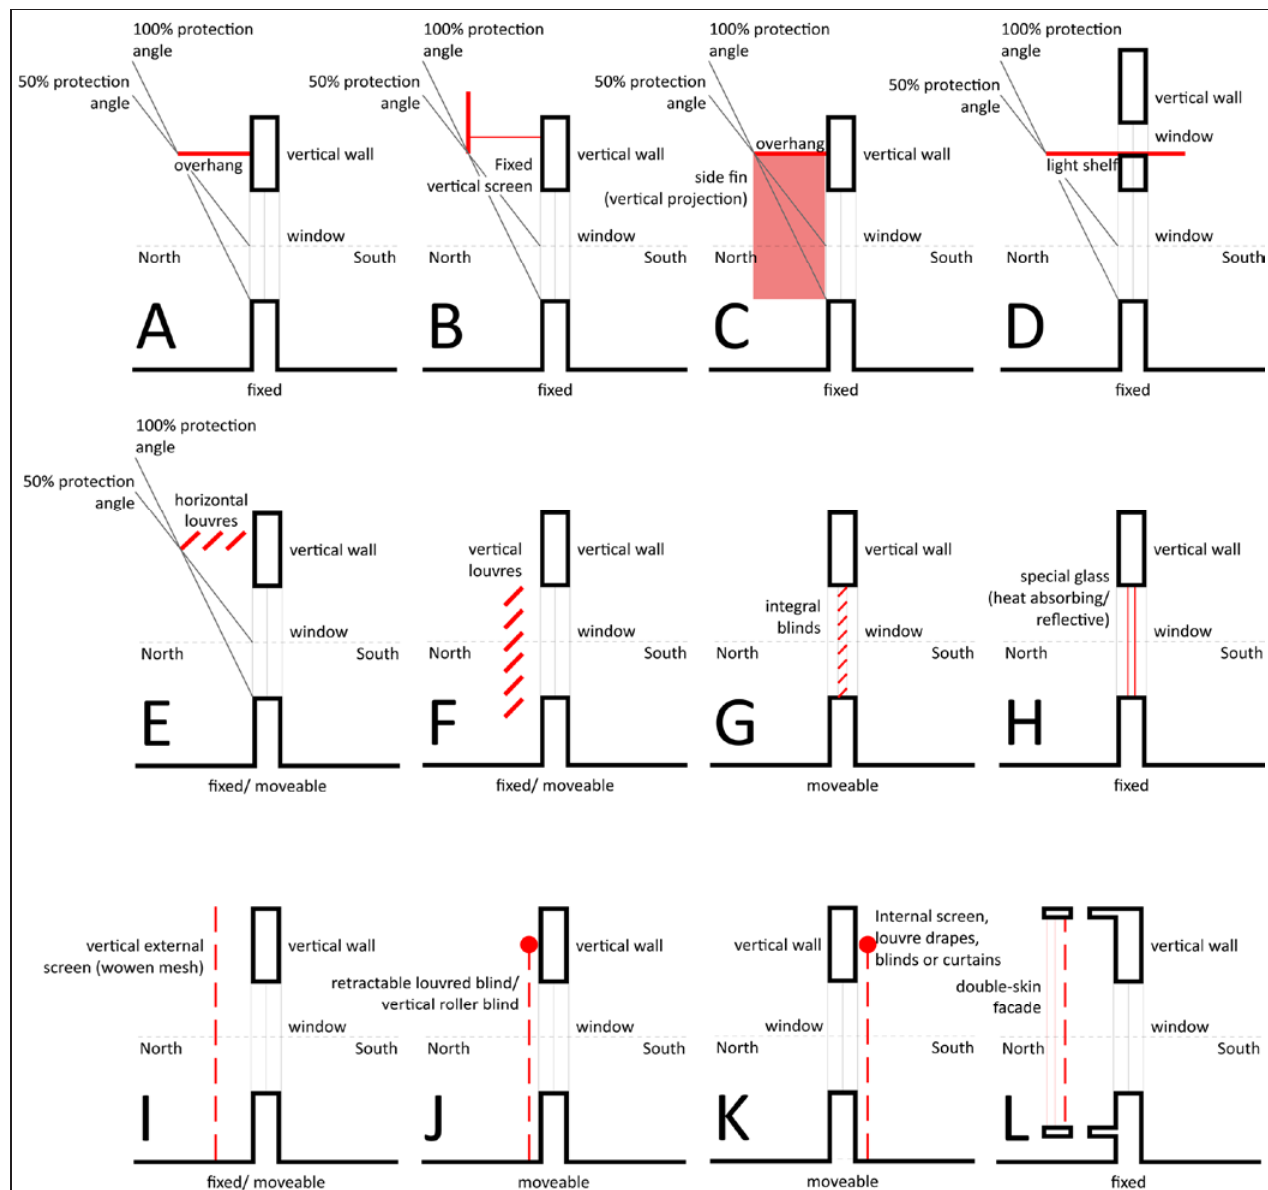
Figure 15: Different types of shading devices